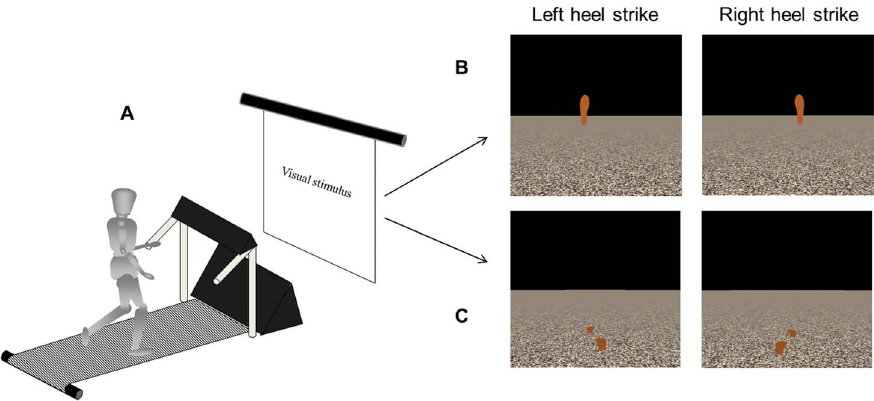
Figure 4. Schematic of the experimental setup in Experiment 2. While treadmill walking at a self-selected speed, the participants synchronized their heel-strike of each limb with the appearance of a corresponding virtual footprint in the virtual environment that was projected on a screen (A) that consisted of either a discrete (B) or continuous virtual stimulus (C). Both virtual environments contained a moving ground plane, providing optic flow of the environment that closely mimicked the treadmill